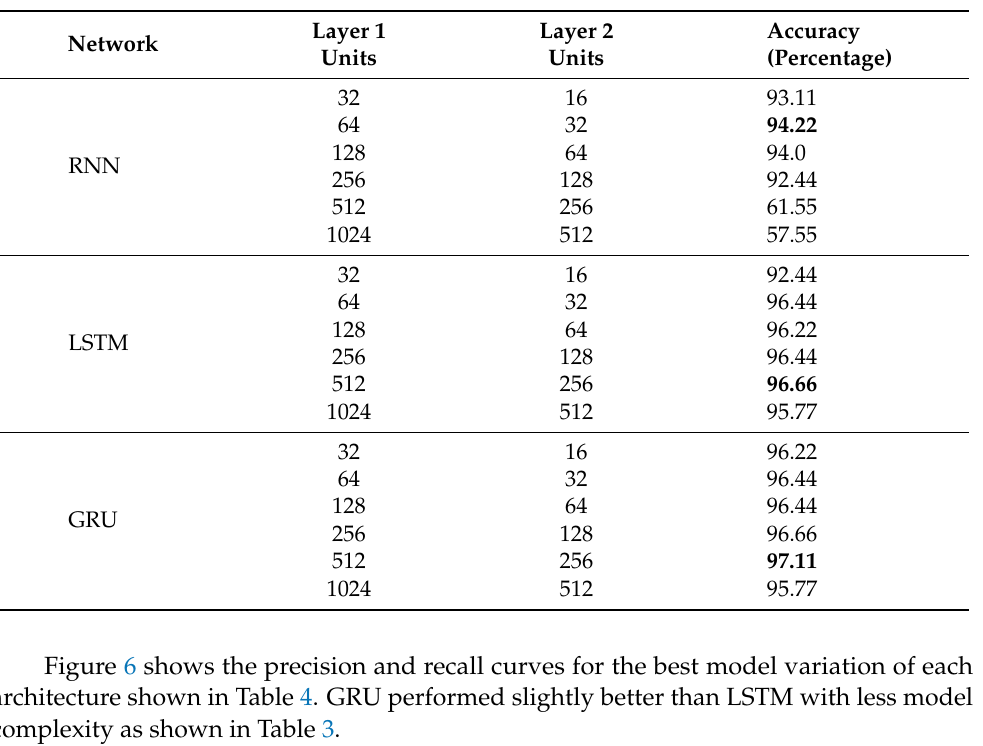
Table 4. Testing accuracy for the different model architectures. The bold numbers represent the variation (row) with the best accuracy. Model variations with large number of units overfit the training data performing poorly on the test data.